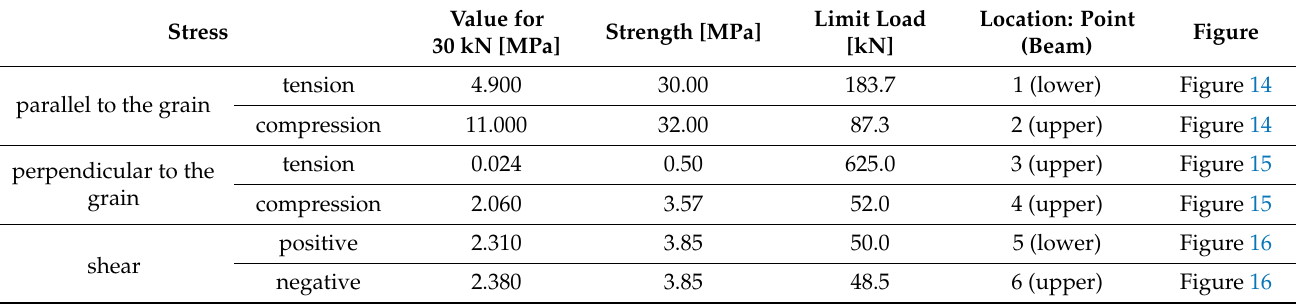
Table 2. Location and values of extreme values of stresses in single-step joint with the information of load at which those values reach respective limits.